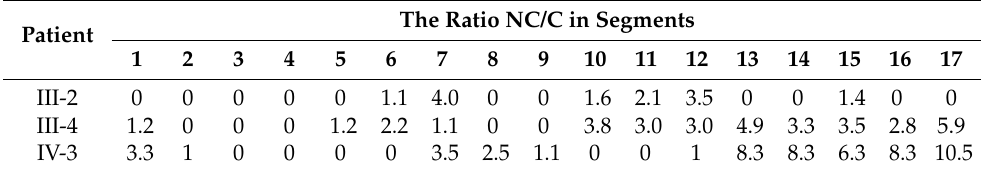
Figure 1. Pedigree of the described family. Circles represent females, squares males. Black-filled symbols indicate left ventricular non-compaction cardiomyopathy phenotype, grey symbols indicate members with an unknown type of cardiomyopathy, and white symbols indicate healthy family members. Backslashes indicate deceased members. +/− represent heterozygous and −/− wild type sequences for the indicated gene. The index patient (III-4) is marked with an arrow. d. = dead, m.o. = months old, y.o. = years old. Table 1. Magnetic resonance imaging data. Ratio of non-compacted/compact layers by segment.